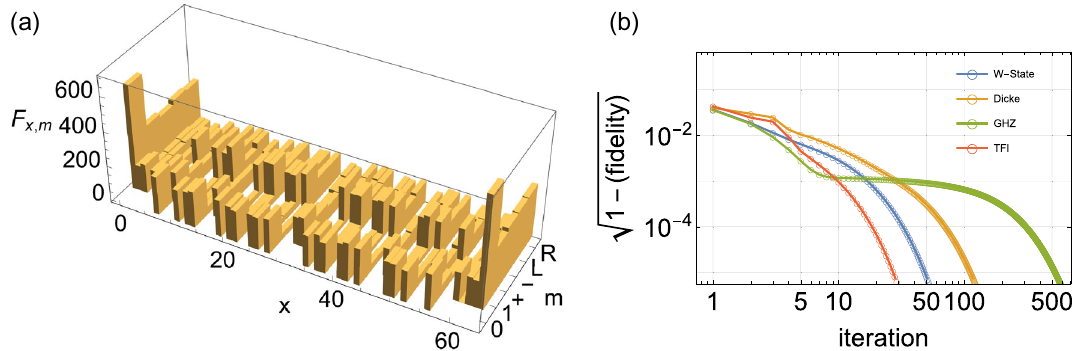
Figure 3. ( a ) Relative frequencies F x , m of the measurement readouts ( x , m ) from the simulation with an ensemble of 24,000 systems in the symmetric Dicke state with six qubits ( F Convergence behaviors of the iterative maximization procedure for different system states (the W state, Dicke state, GHZ state, and the ground state of the transverse field Ising model in the ordered phase) exhibited by the fidelity between the states from consecutive iterations. For all the four cases, the fidelities between the resulting states and the true wavefunctions, respectively, are better than